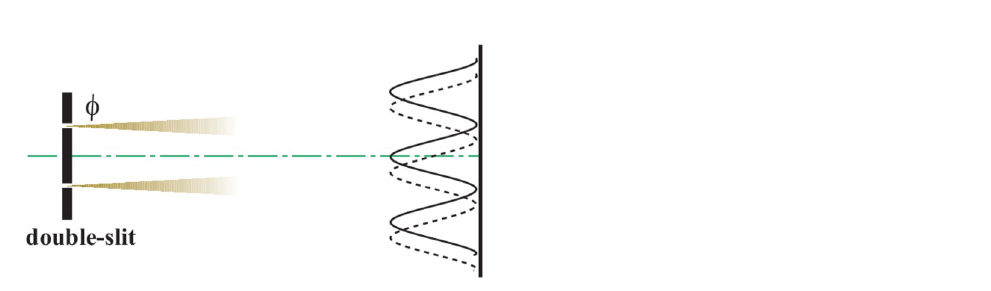
Figure 1. Experimental setup. A laser beam passes through a rotating ground glass to generate pseudo-thermal light. A double-slit is placed after the ground glass. A CCD camera records the speckles scattered from the double-slit.